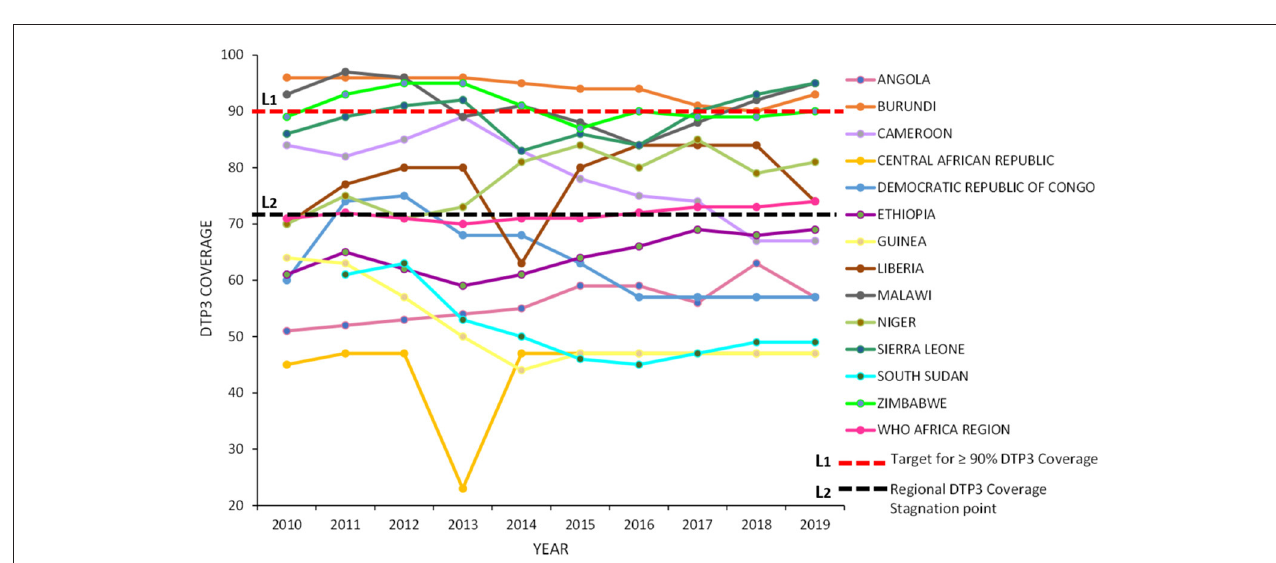
FIGURE 4 | Annual DTP3 coverage trends between 2010 and 2019 for the 13 countries and the WHO Africa region.